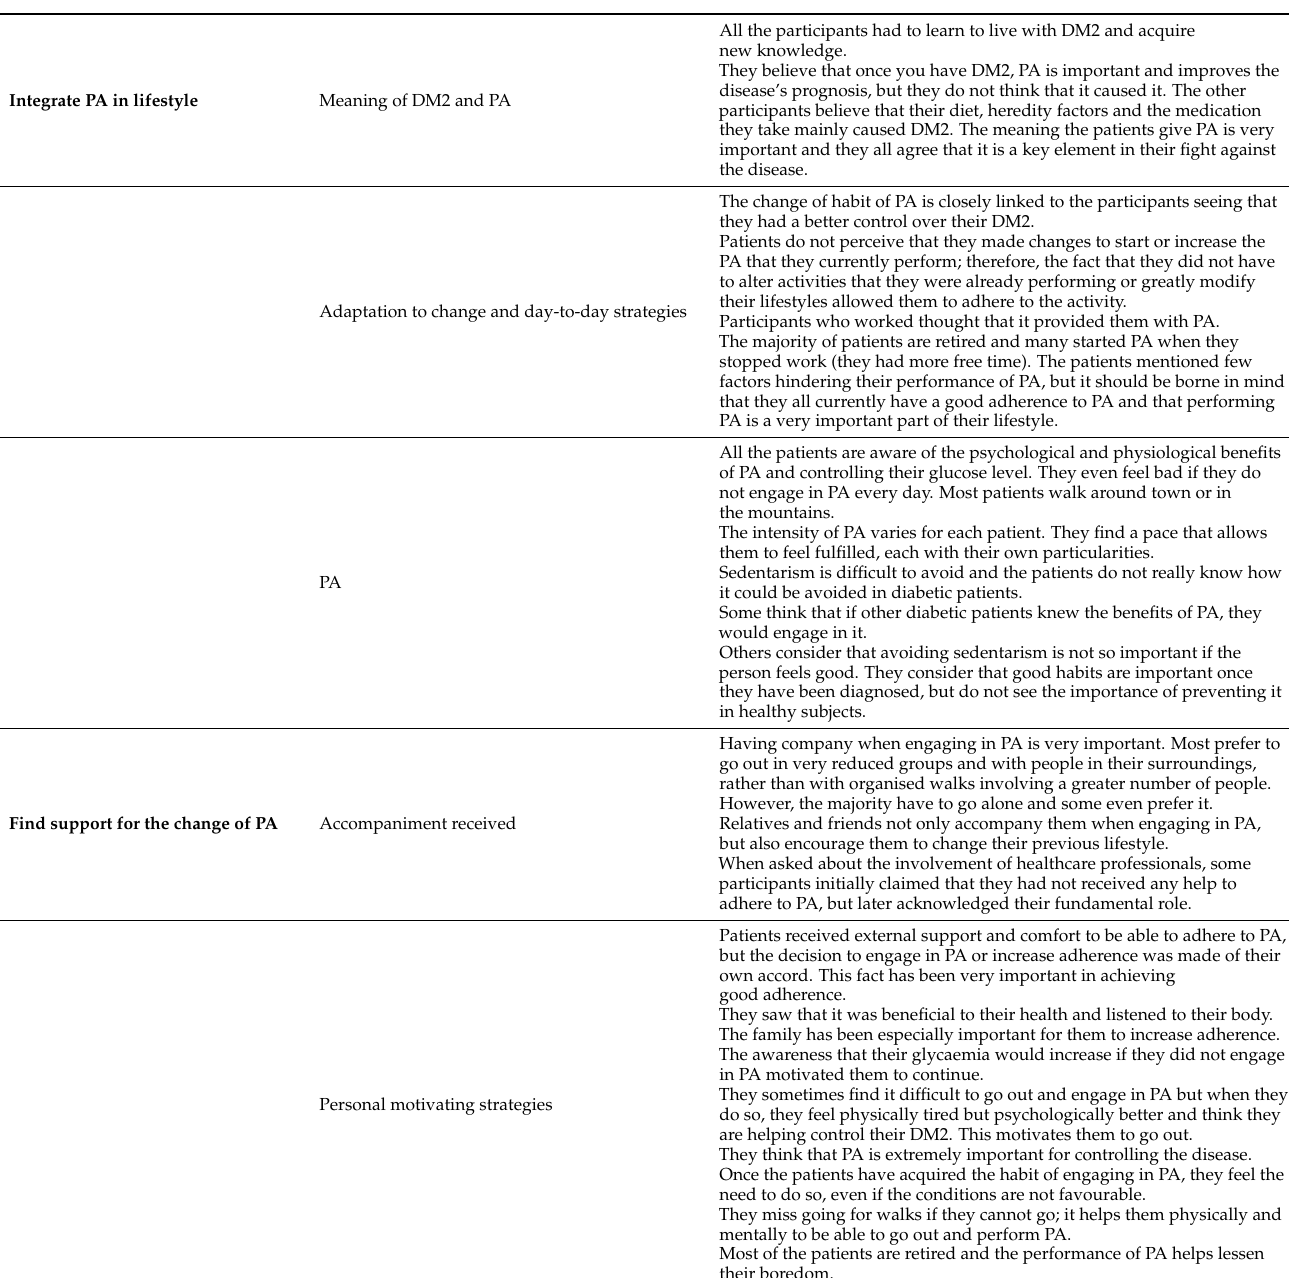
Table 3 highlights and summarizes the essence of the research conducted: Table 3. Themes, categories and essence of the research